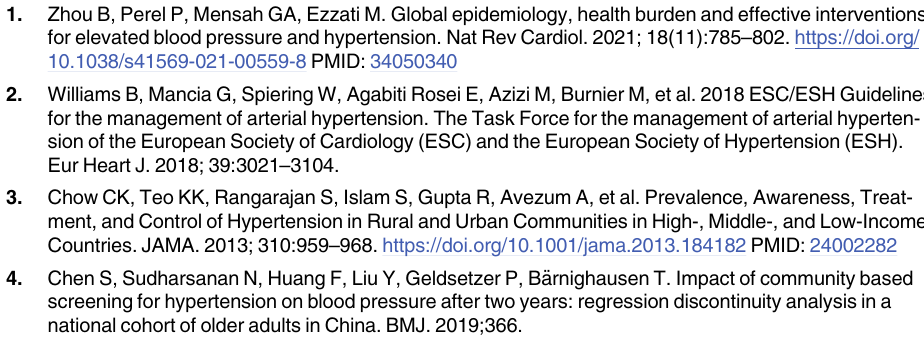
S3 Table. Description of analytic sample for the outcome “any CVD event.” (PDF) S4 Table. Full information on covariate balance